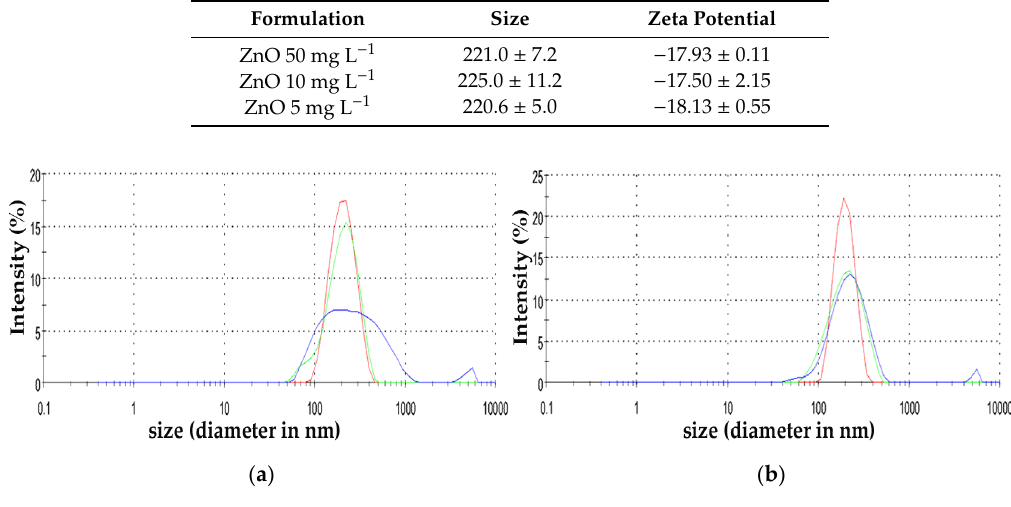
Figure 3. Size distribution by intensity of 5 mg L − 1 ZnO NPs ( a ); and 10 mg L − 1 ZnO NPs ( b ). Different colours indicate the replications.